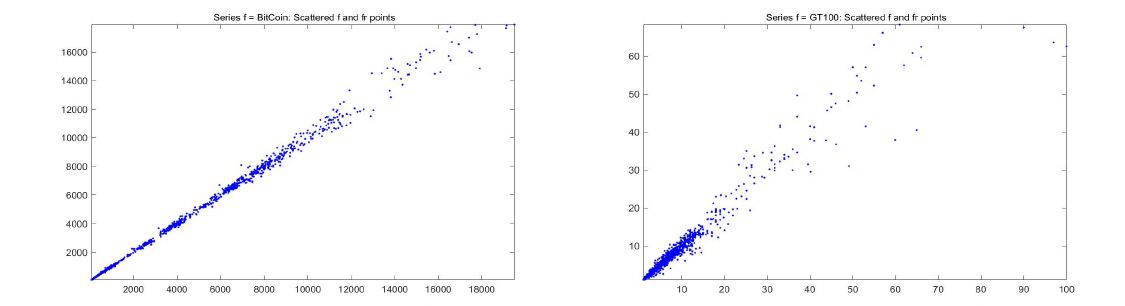
) for daily Bitcoin prices ( left picture) and daily GT100 trends ( right ), Figure 2. Scatter-plots of ( f t , f r t from April 2013 to June